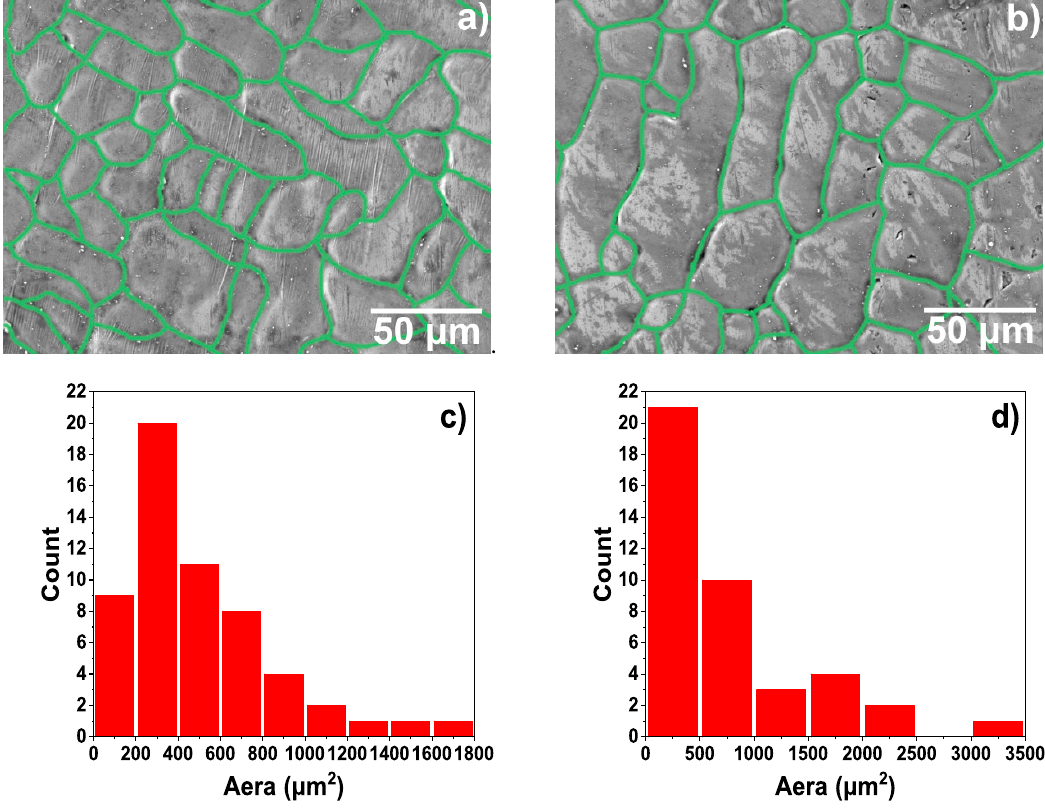
Figure 2. Grain boundary diagram and the grain distribution of hot-dip aluminised coatings obtained by image analysis: ( a ) and ( c ) T ‐ 1 sample, ( b ) and ( d ) T ‐ 2 sample.